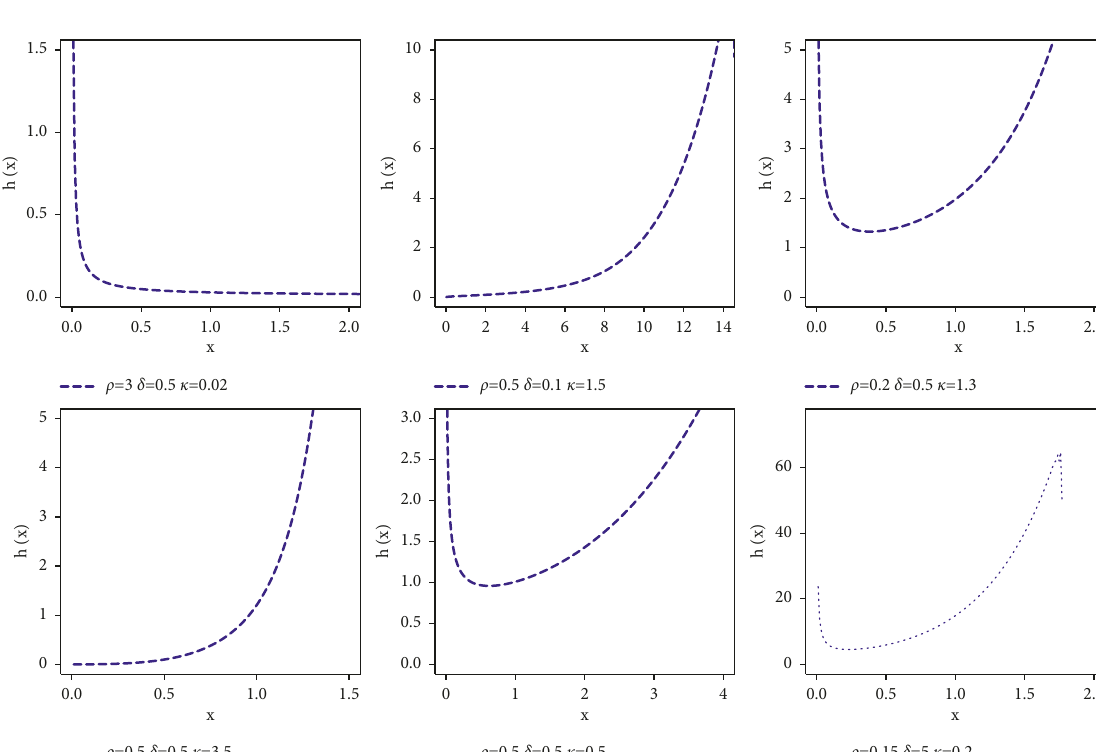
Figure 2: HRF plots of BXLE distribution.